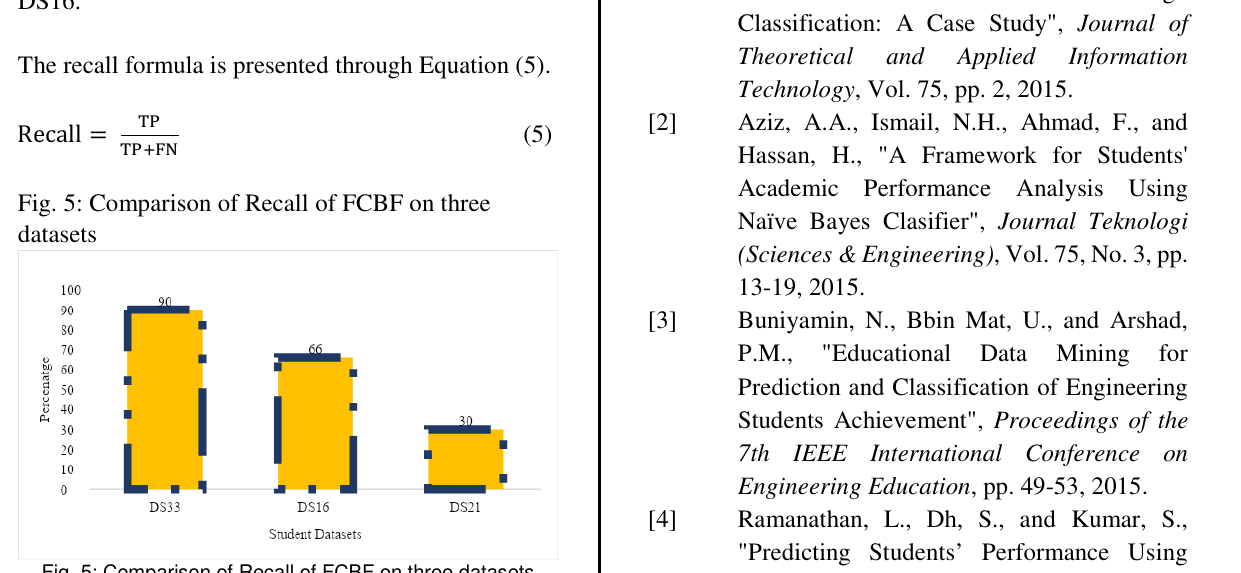
Fig. 5: Comparison of Recall of FCBF on three datasets